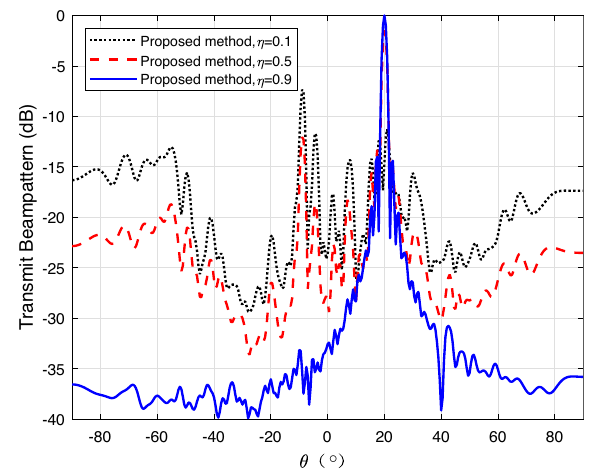
Fig. 6 The transmit beampattern versus tradeoff parameter η with the SNR = 0 dB